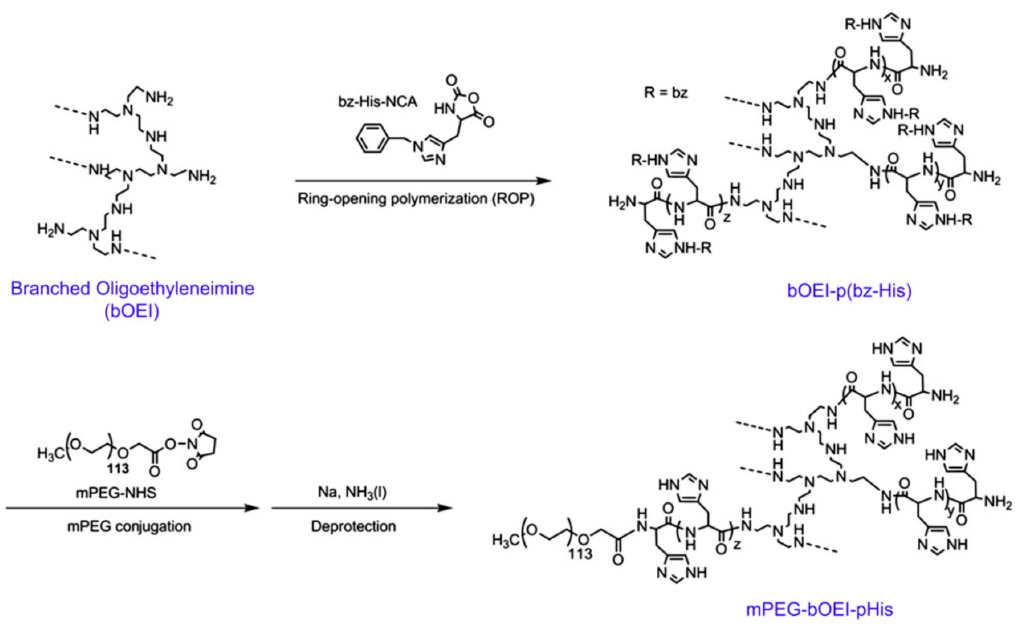
Figure 39. Synthesis of star-shaped block copolymer composed of methoxy poly(ethylene glycol) (mPEG), branched oligoethylenimine (bOEI), and poly(L-histidine) (pHis) via the multi-initiation and ring-opening polymerization (ROP). Reproduced with permission from reference [190].